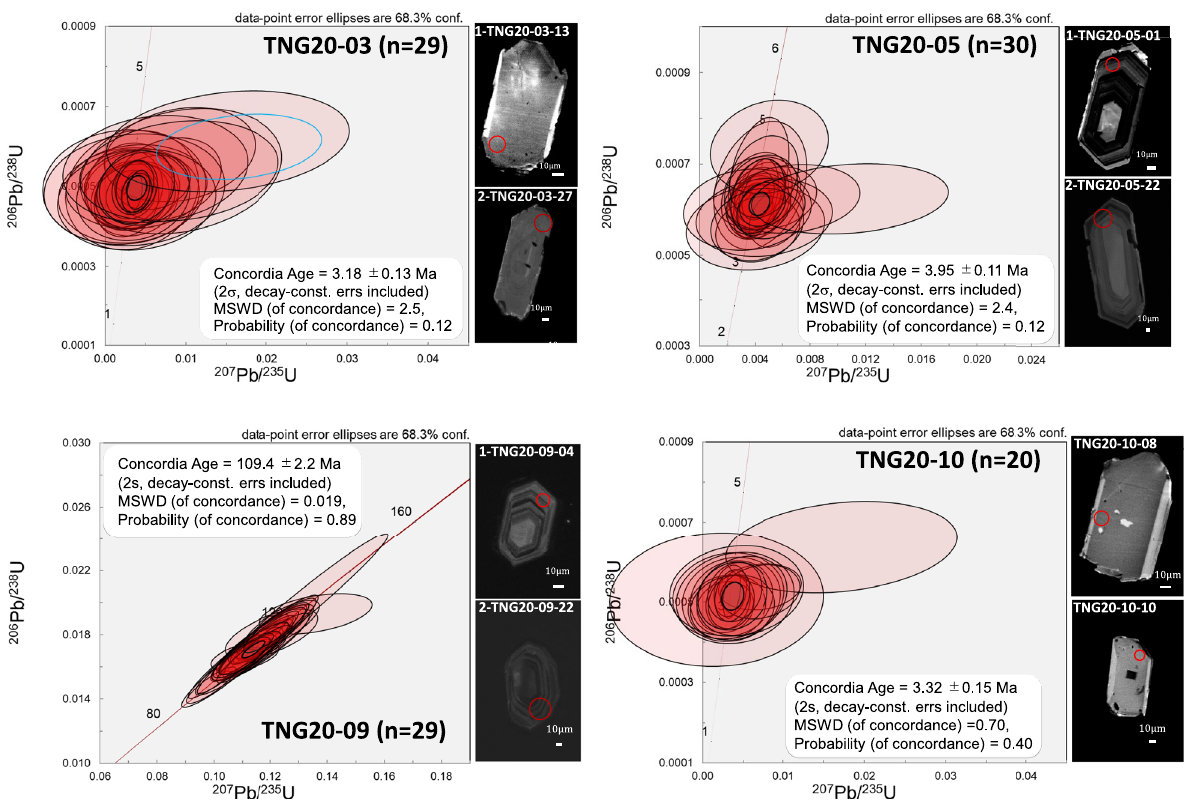
Fig. 2 The concordia diagrams and the cathodoluminescence images. The diagrams were drawn by using Isoplot 4.15 (Ludwig 2012). In the concordia diagrams, red solid circles indicate concordant dates and blue open circles mean discordant dates within the error range of 1 sigma. The heavy line circles are the concordia ages with 2 sigma errors, calculated from the concordant data. The discordant data of TNG20-09 are not displayed because it is away from the concordant curve. The red open circles in the CL images signify the analytical